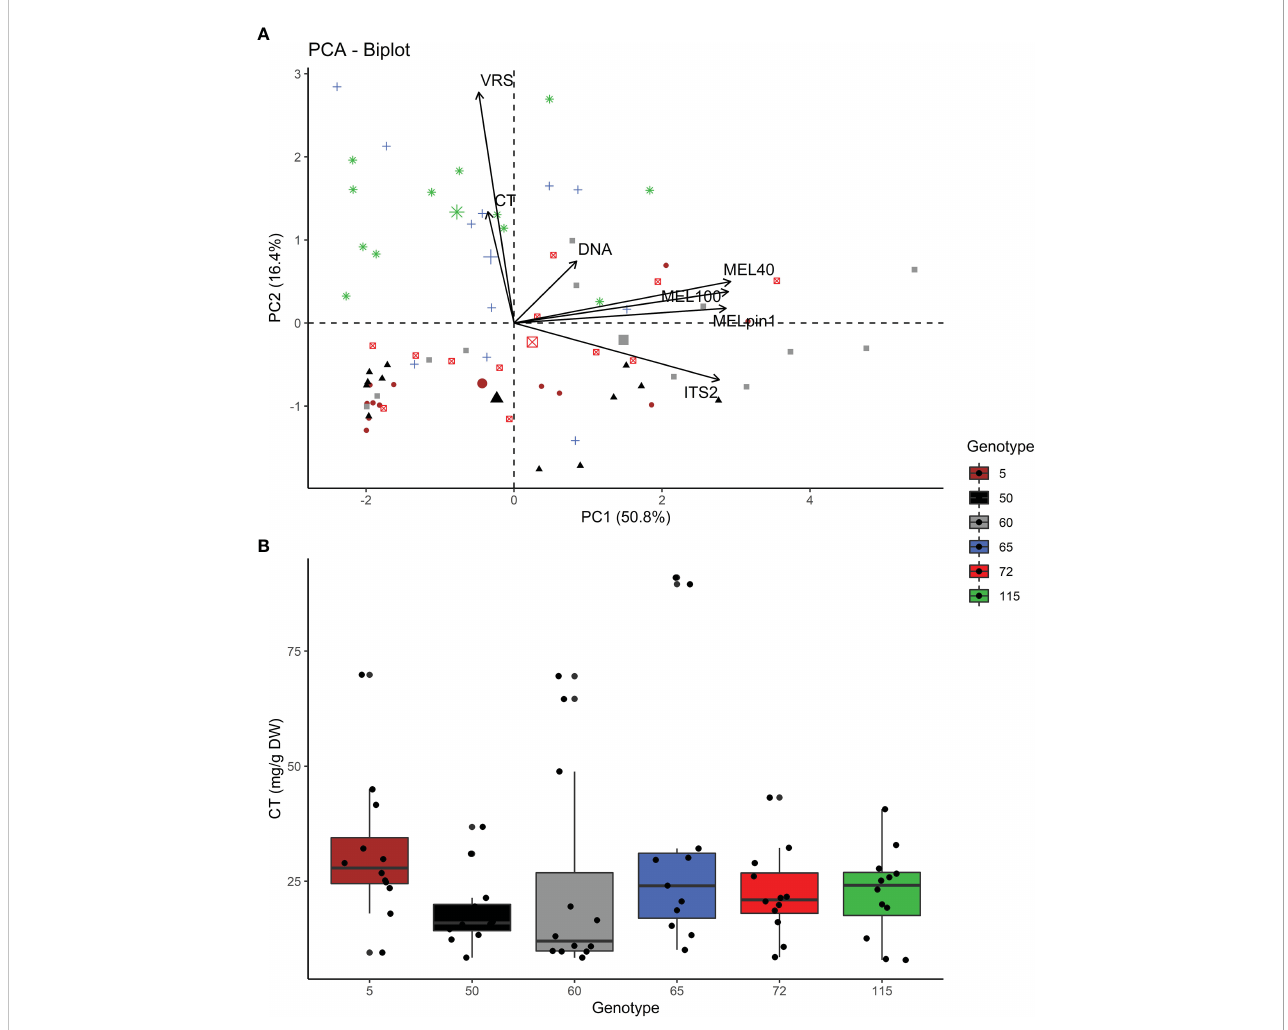
FIGURE 4 (A) PCA biplot showing the relationships between the studied indicators of fungal infestation at genotypic level: VRS (visual rust score), foliar condensed tannin content (CT), DNA concentration, and the PCR concentration (ng/ml) for the marker genes of general fungal colonization (the ITS2 fungal rDNA sequence ampli fi ed using ITS3+ITS4 primers), the Melampsora genus (ampli fi ed using the MEL40 and MEL100 primers), and the native rust M. pinitorqua (ampli fi ed using the MELpin1 primers). Colors and shapes represent the observation for individual genotypes. Correlations between the responses are shown in Figure 5. (B) Foliar concentrations of condensed tannins (CT) in the six studied aspen genotypes and expressed as mg/g dry weight (mg/g